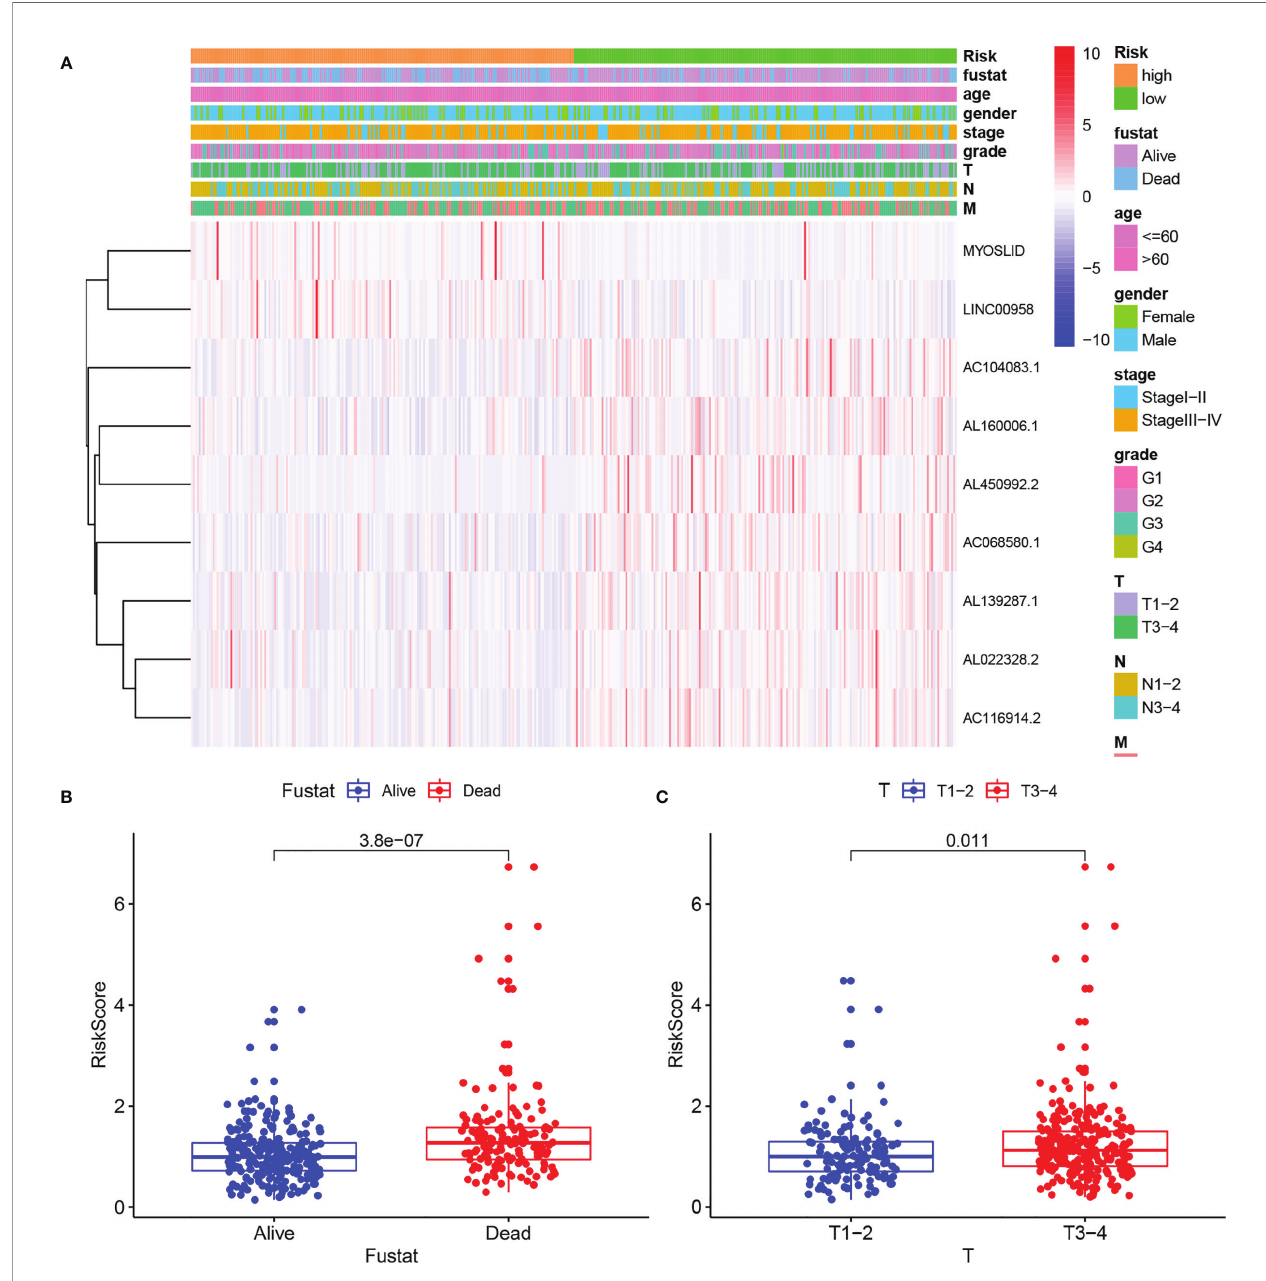
FIGURE 3 | Correlation of risk score with clinical parameters. (A) Heatmaps of clinical parameters and autophagy-related LncRNAs between high- and low-risk groups. (B) Boxplot of risk score difference between alive and dead groups. (C) Boxplot of risk score difference between T stage1 – 2 and T stage 3 –